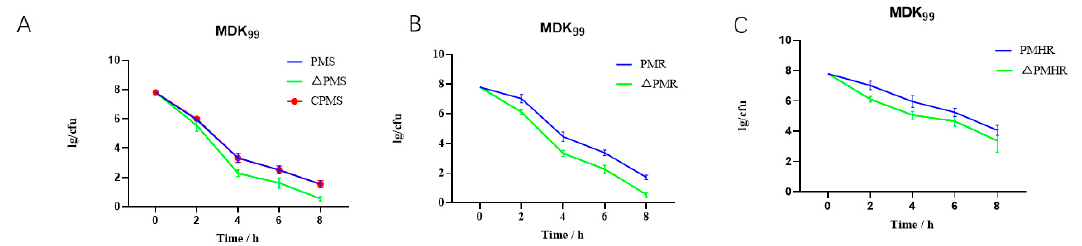
Figure 4. The expression level of the satP gene in the wild-type S, deletion satP . MDK 99 and survival proportions. ( A – C ) MDK 99 of PmS , PmR , PmHR , Δ PmS , Δ PmR and Δ PmHR.